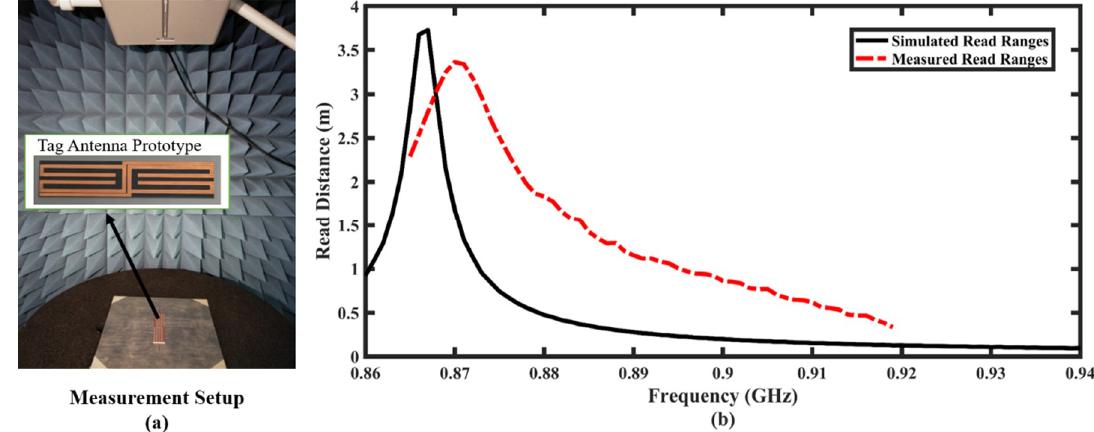
Figure 6. Simulated radiation pattern at resonance frequency for the miniature tag antenna; ( a ) X–Z plane; ( b ) X–Y plane; and ( c ) radiation pattern.